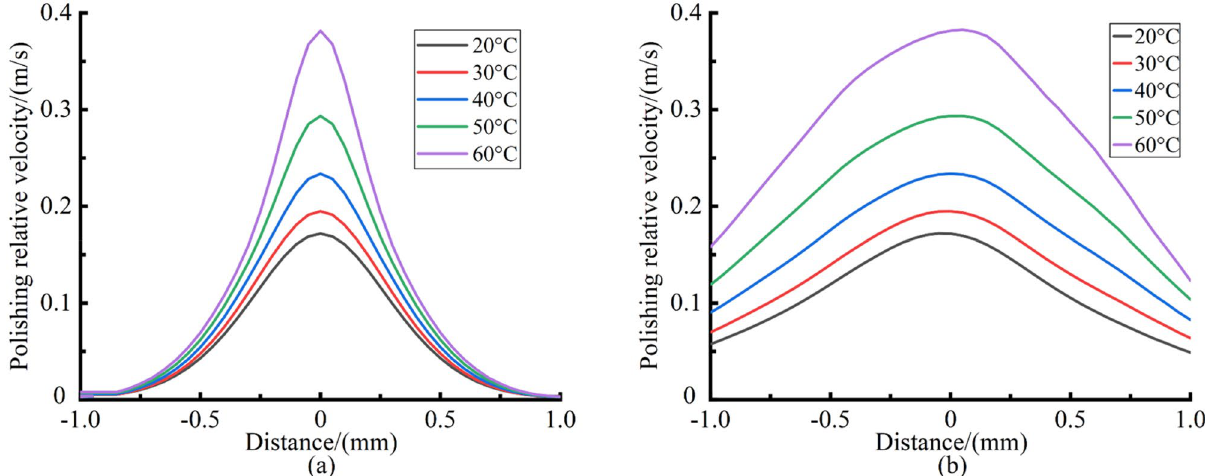
Figure 6. Polishing relative velocity distribution curves. ( a ) Along the X axis; ( b ) Along the Z